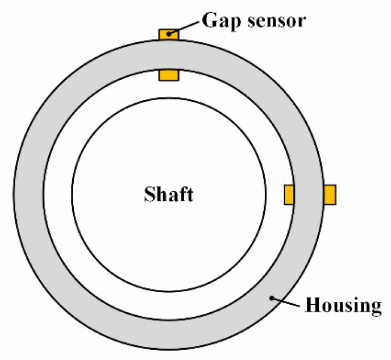
Figure 15. Conceptual view of a rotor vibration measurement system.